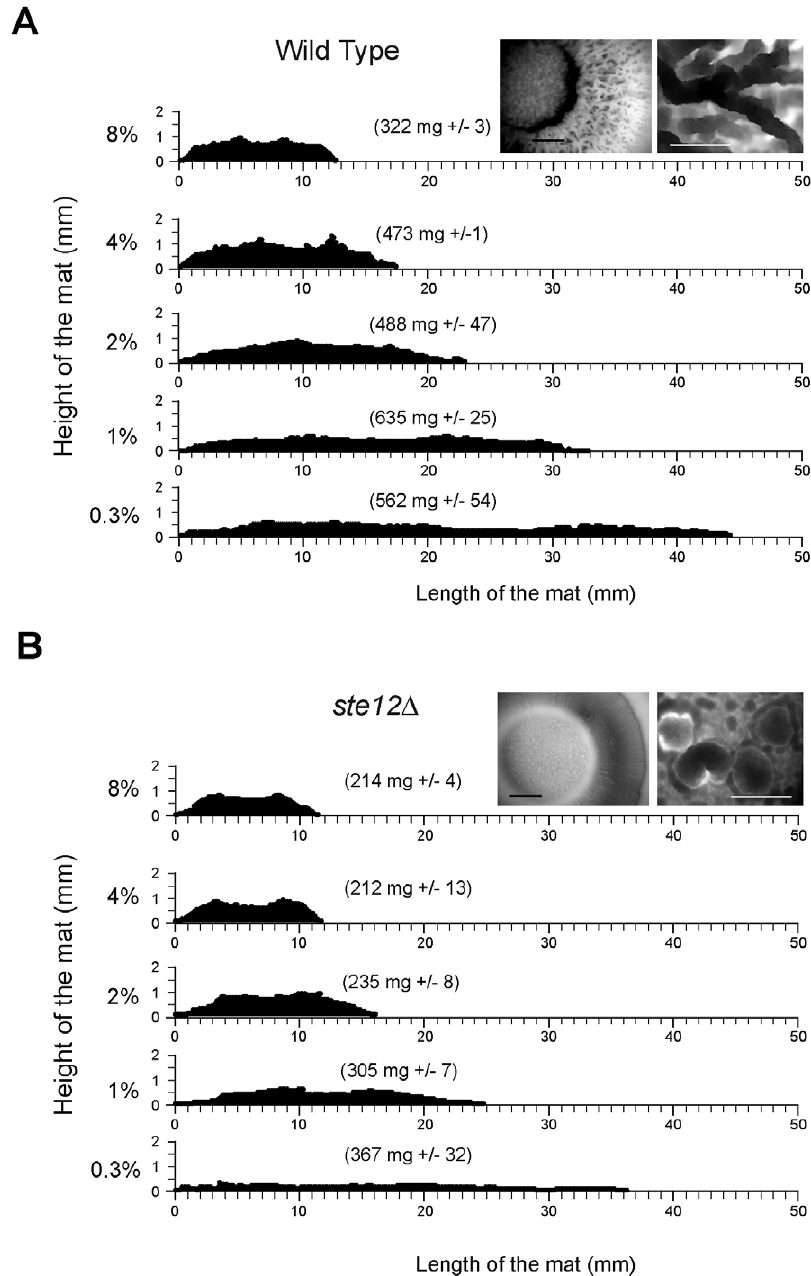
Figure 4. The role of the MAPK pathway in regulating mat architecture when exposed to surfaces of different rigidities. A ) Contour maps in the Z-axis of wild type (PC538) mats incubated in media of different agar concentrations for 14d. Insets show mat morphology (left, photograph, bar, 1 cm; right, photomicrograph, bar, 200 microns) in 4% agar. The numbers in parentheses represent the average mat dry weight from two experiments with standard deviation shown. Scale bars for the X and Y-axes are in mm. B ) Mats formed by a ste12 D mutant (PC539) on different agar concentrations. Analysis is as described for panel A.